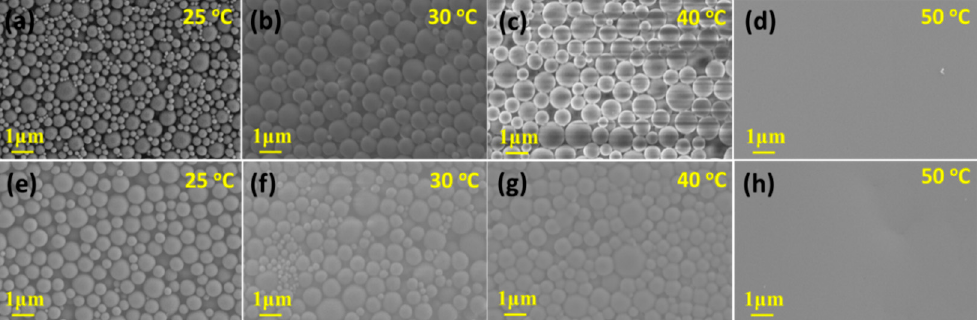
Figure 6. SEM observation of ( a – d ) 20-TIPS + DE samples and ( e – h ) 60-TIPS + DE samples at different evaporation temperature.